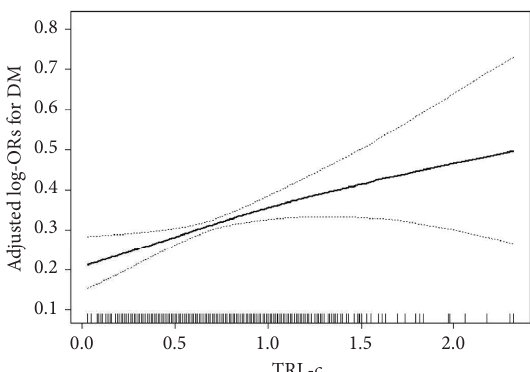
Figure 2: Dose-response association between TRL-c and DM. All were adjusted for age, gender, BMI, current smoking, SBP, Hcy, history of hypertension and atrial fbrillation, and antihypertensive